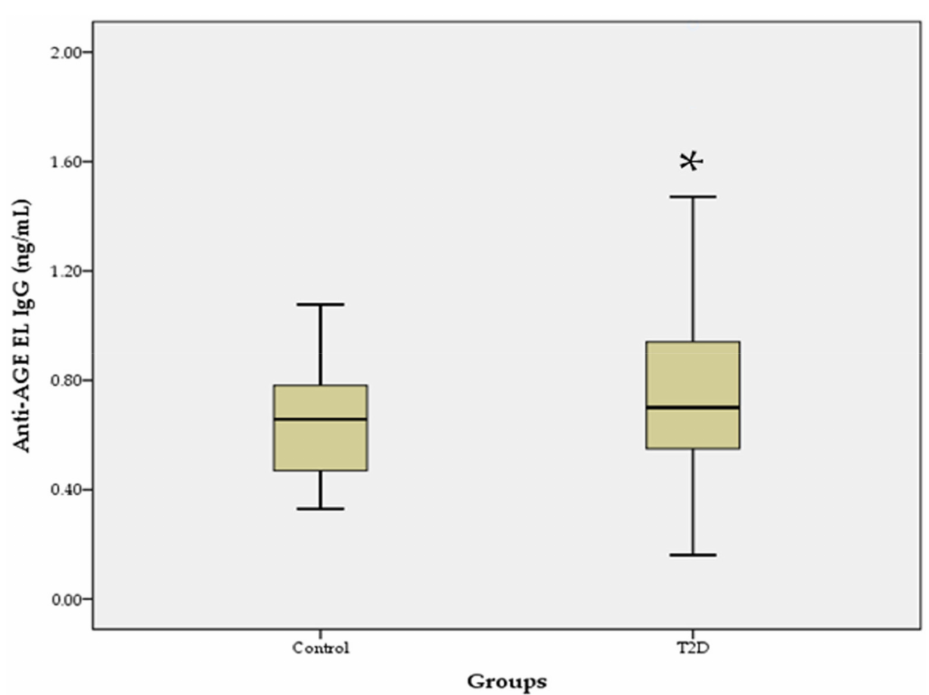
Figure 1. Serum levels of anti-AGE EL IgG antibodies in the T2D group compared to the control group. Data are represented as mean ± SD. * p < 0.05.